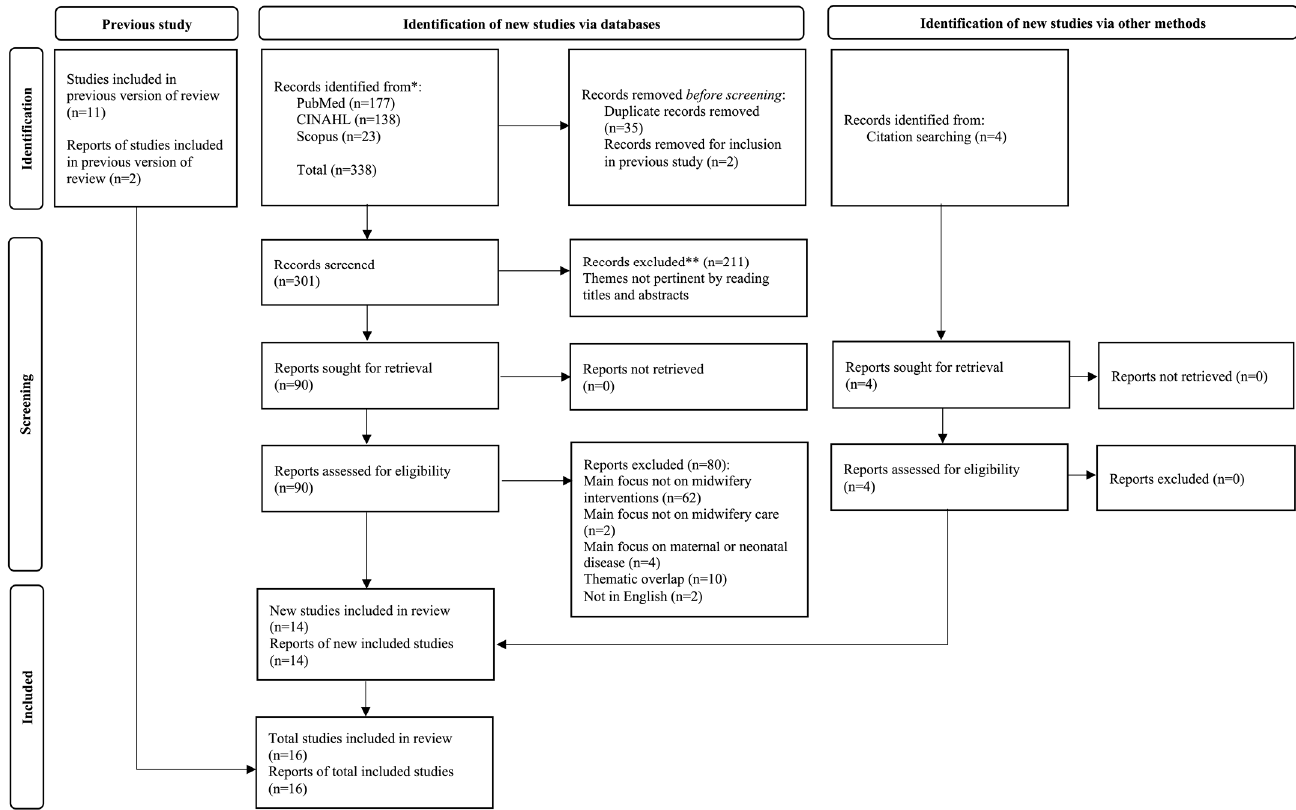
Figure 2. Selection flow diagram. Legend: * indicates the first identification phase; ** indicates excluded records